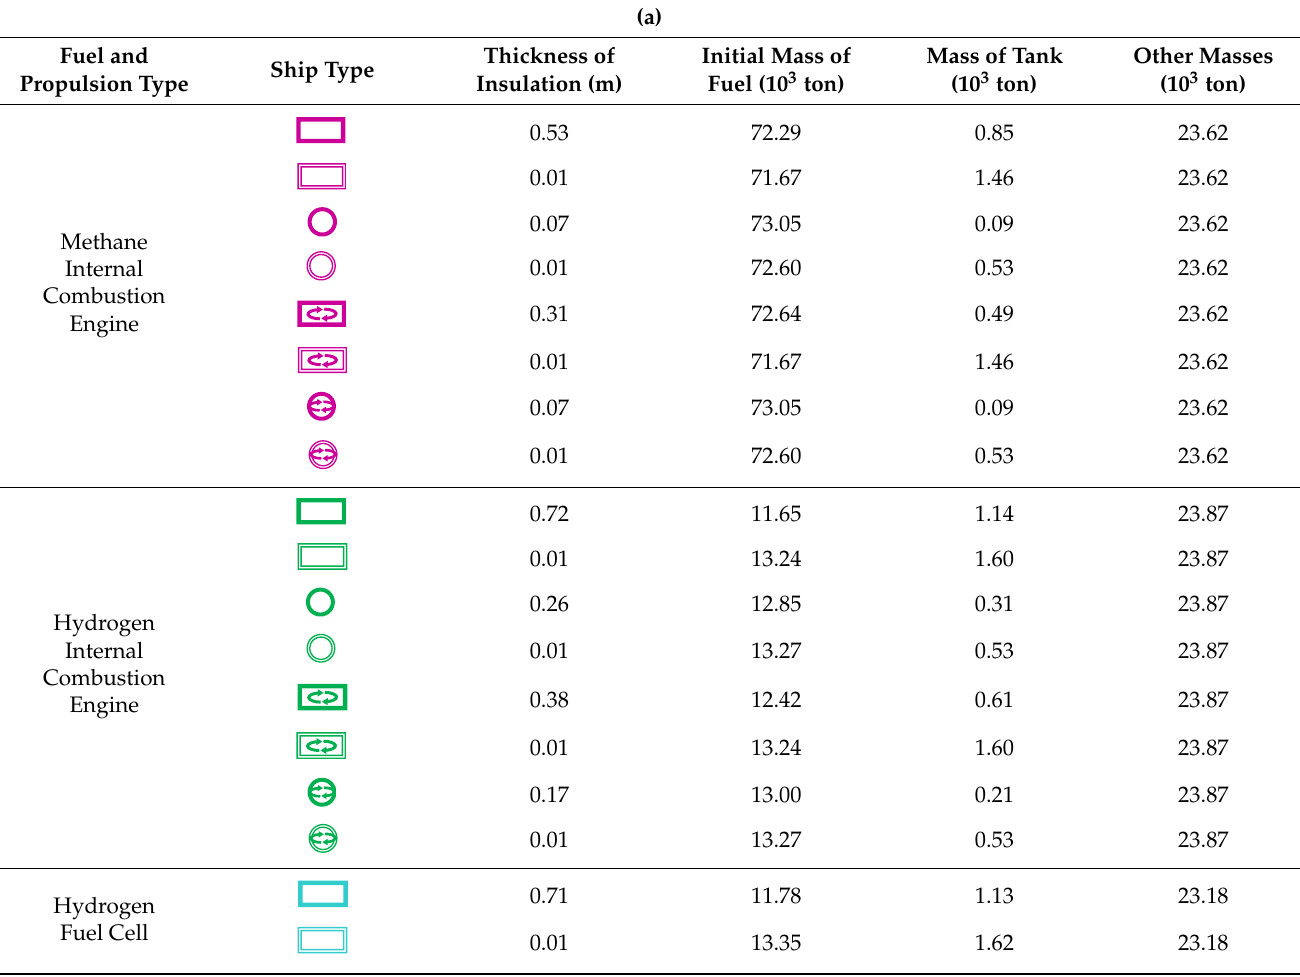
28 of 32 28 of 32 28 of 32 28 of 32 LH2 ship with vacuum insulated spherical tanks that does not use reliquefaction. The re- LH2 ship with vacuum insulated spherical tanks that does not use reliquefaction. The re- sulting loss in delivered fuel is 0.88% at 5000 km and 2.7% at 15,000 km, which is equiva- sulting loss in delivered fuel is 0.88% at 5000 km and 2.7% at 15,000 km, which is equiva- LH2 ship with vacuum insulated spherical tanks that does not use reliquefaction. The re- LH2 ship with vacuum insulated spherical tanks that does not use reliquefaction. The re- lent to a revenue loss of $93,000 at 5000 km and $279,000 at 15,000 km [73,74]. LH2 ship with vacuum insulated spherical tanks that does not use reliquefaction. The re- sulting loss in delivered fuel is 0.88% at 5000 km and 2.7% at 15,000 km, which is equiva- Table A7. Estimated ship properties, set to maximise the delivered mass after 20 days for all inves- Table A7. Estimated ship properties, set to maximise the delivered mass after 20 days for all inves- Table A7. Estimated ship properties, set to maximise the delivered mass after 20 days for all inves- Table A7. Estimated ship properties, set to maximise the delivered mass after 20 days for all sulting loss in delivered fuel is 0.88% at 5000 km and 2.7% at 15,000 km, which is equiva- Table A7. Estimated ship properties, set to maximise the delivered mass after 20 days for all inves- Table A7. Estimated ship properties, set to maximise the delivered mass after 20 days for all inves- Table A7. Estimated ship properties, set to maximise the delivered mass after 20 days for all inves- tigated ship designs: (a) thickness of insulation and component masses; (b) component volumes, Table A7. Estimated ship properties, set to maximise the delivered mass after 20 days for all inves- tigated ship designs: (a) thickness of insulation and component masses; (b) component volumes, Table A7. Estimated ship properties, set to maximise the delivered mass after 20 days for all inves- tigated ship designs: (a) thickness of insulation and component masses; (b) component volumes, tigated ship designs: (a) thickness of insulation and component masses; (b) component volumes, investigated ship designs: (a) thickness of insulation and component masses; (b) component volumes, tigated ship designs: (a) thickness of insulation and component masses; (b) component volumes, Table A7. Estimated ship properties, set to maximise the delivered mass after 20 days for all inves- tigated ship designs: (a) thickness of insulation and component masses; (b) component volumes, Table A7. Estimated ship properties, set to maximise the delivered mass after 20 days for all inves- fuel depletion rate, and revenue loss rate [73,74] . tigated ship designs: (a) thickness of insulation and component masses; (b) component volumes, Table A7. Estimated ship properties, set to maximise the delivered mass after 20 days for all inves- fuel depletion rate, and revenue loss rate [73,74] . Table A7. Estimated ship properties, set to maximise the delivered mass after 20 days for all inves- tigated ship designs: (a) thickness of insulation and component masses; (b) component volumes, fuel depletion rate, and revenue loss rate [73,74] . fuel depletion rate, and revenue loss rate [73,74] . Table A7. Estimated ship properties, set to maximise the delivered mass after 20 days for all inves- fuel depletion rate, and revenue loss rate [73,74]. fuel depletion rate, and revenue loss rate [73,74] . Table A7. Estimated ship properties, set to maximise the delivered mass after 20 days for all inves- tigated ship designs: (a) thickness of insulation and component masses; (b) component volumes, fuel depletion rate, and revenue loss rate [73,74] . tigated ship designs: (a) thickness of insulation and component masses; (b) component volumes, Table A7. Estimated ship properties, set to maximise the delivered mass after 20 days for all inves- fuel depletion rate, and revenue loss rate [73,74] . tigated ship designs: (a) thickness of insulation and component masses; (b) component volumes, Table A7. Estimated ship properties, set to maximise the delivered mass after 20 days for all inves- tigated ship designs: (a) thickness of insulation and component masses; (b) component volumes, fuel depletion rate, and revenue loss rate [73,74] . tigated ship designs: (a) thickness of insulation and component masses; (b) component volumes, Table A7. Estimated ship properties, set to maximise the delivered mass after 20 days for all inves- Table A7. Estimated ship properties, set to maximise the delivered mass after 20 days for all inves- tigated ship designs: (a) thickness of insulation and component masses; (b) component volumes, fuel depletion rate, and revenue loss rate [73,74] . fuel depletion rate, and revenue loss rate [73,74] . tigated ship designs: (a) thickness of insulation and component masses; (b) component volumes, fuel depletion rate, and revenue loss rate [73,74] . tigated ship designs: (a) thickness of insulation and component masses; (b) component volumes, ( a ) fuel depletion rate, and revenue loss rate [73,74] . ( a ) fuel depletion rate, and revenue loss rate [73,74] . ( a ) tigated ship designs: (a) thickness of insulation and component masses; (b) component volumes, tigated ship designs: (a) thickness of insulation and component masses; (b) component volumes, fuel depletion rate, and revenue loss rate [73,74] . fuel depletion rate, and revenue loss rate [73,74] . fuel depletion rate, and revenue loss rate [73,74] . ( a ) fuel depletion rate, and revenue loss rate [73,74] . fuel depletion rate, and revenue loss rate [73,74] ( a ) ( a )